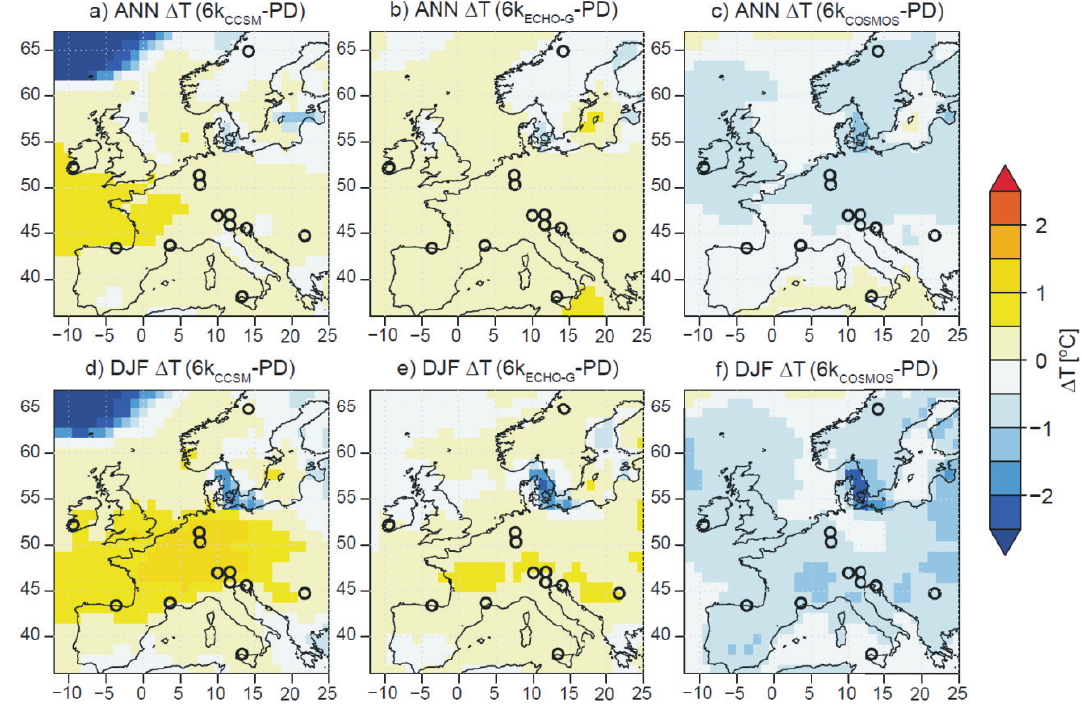
Fig. 3. Temperature anomalies (6k-PD) in Europe as simulated by ECHAM5-wiso forced by sea surface temperatures and sea ice cover extracted from transient Holocene simulations performed with three different fully coupled ocean-atmosphere models (CCSM, COSMOS, ECHO-G). First row: annual mean temperature, second row: winter temperature.